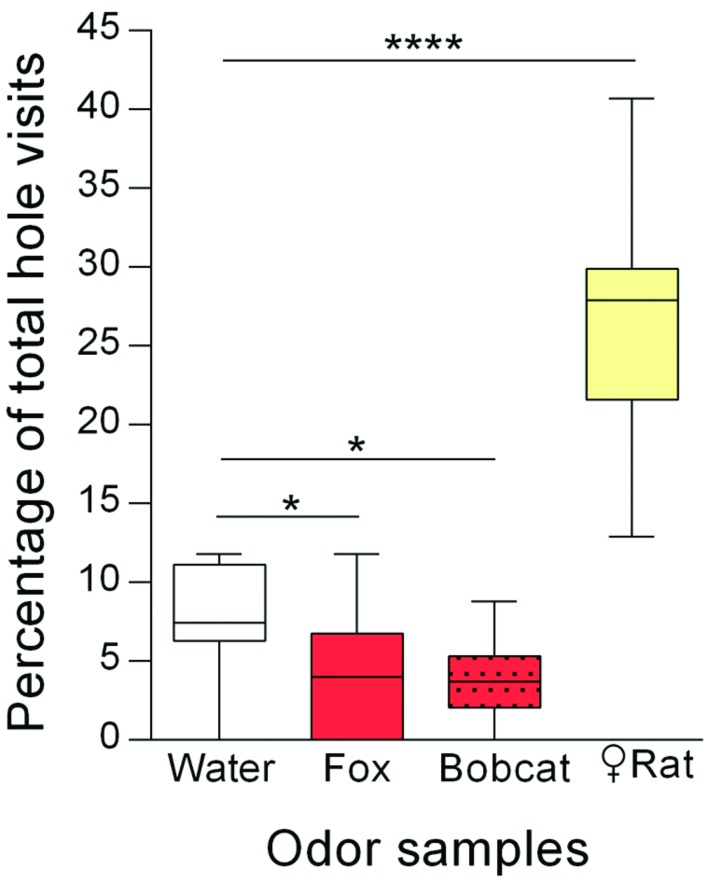
Rats (n = 14) avoided holes with carnivore urine whereas holes with female rat urine were preferred. Percentages of total hole visits (median) for the different corner holes are shown. ∗p < 0.05; ∗∗∗∗p < 0.0001 comparisons as indicated (Holm-Sidak’s multiple comparison test after significant main effects in an ANOVA).